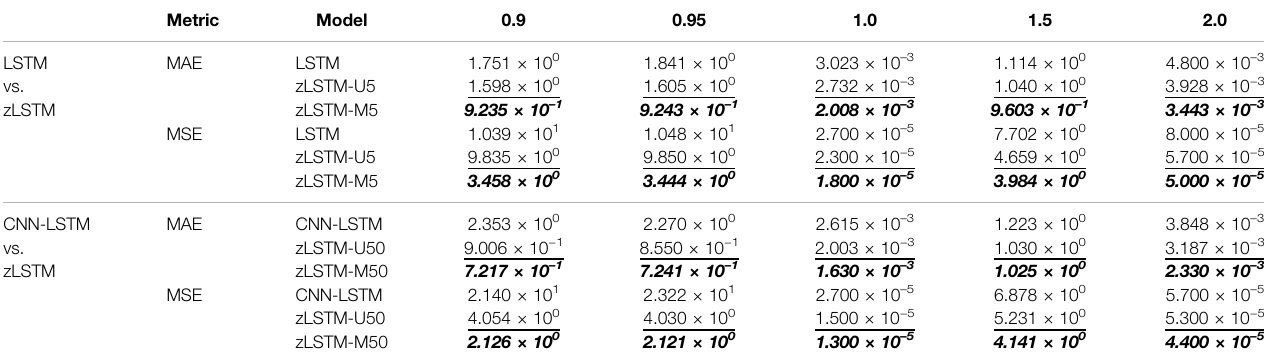
TABLE 2 | Prediction accuracy evaluations for loop 1 fl owrate.